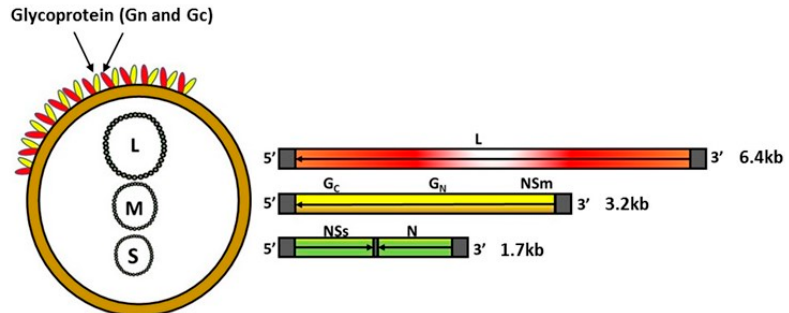
Figure 1. Schematic illustration of RVFV genome organization. Left panel shows the virion containing small (S), medium (M), and large (L) RNA segments; the panel also shows the surface glycoproteins Gn and Gc incorporated into the envelope lipid bilayer. Left panel shows the schematic representation of the RNA segments and the coding strategy. L = L protein; NSm = non-structural protein M; glycoproteins Gn, Gc; N = nucleoprotein; NSs = non-structural protein S. The arrows indicate the coding strategy of the virus.